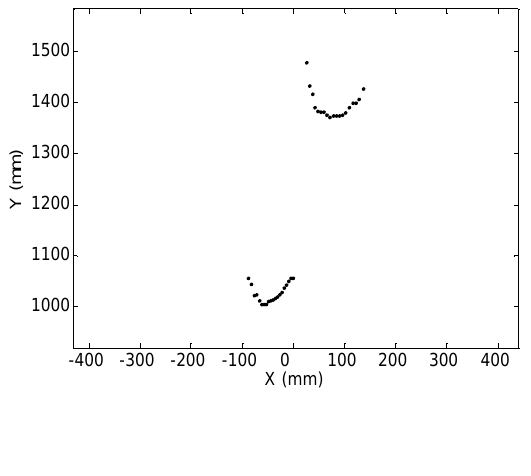
Figure 3. Example of LIDAR raw data points showing two legs.